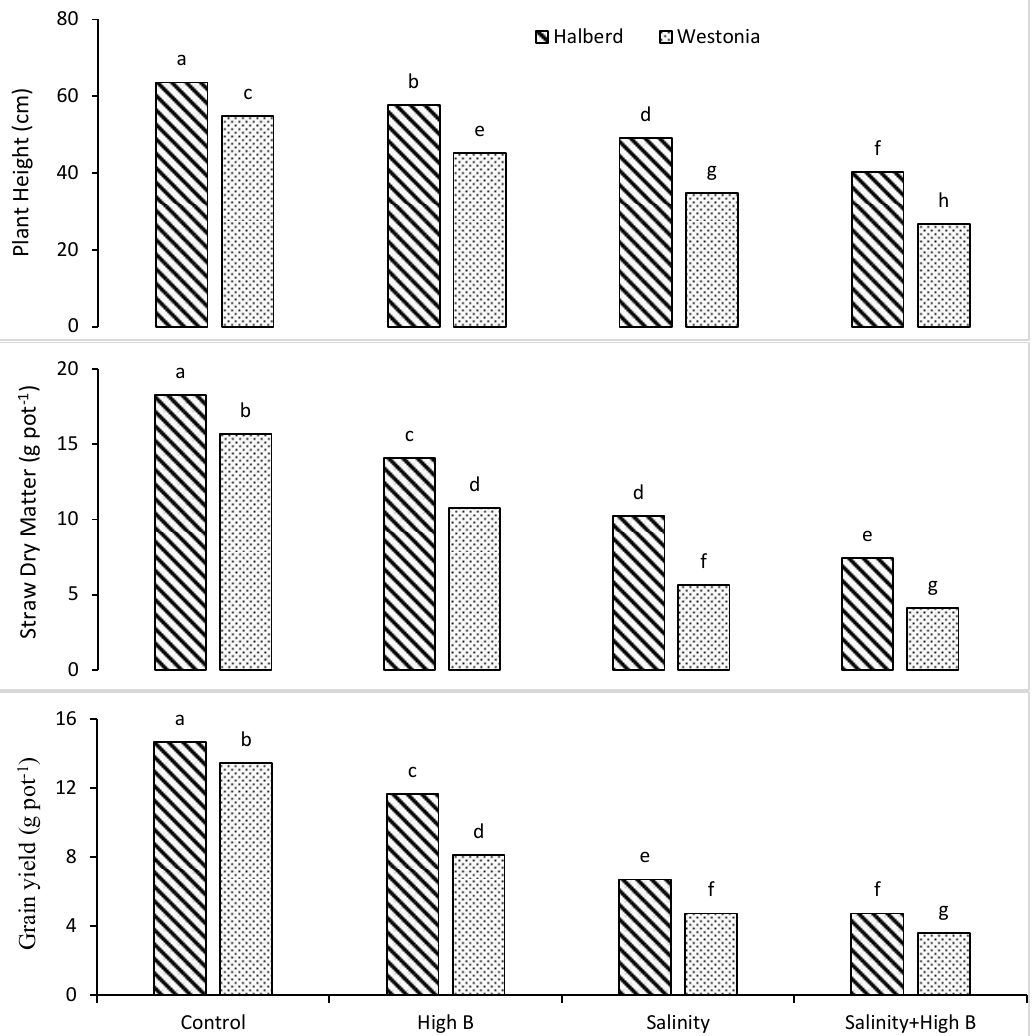
Figure 1. Impact of soil salinity and high B on the plant height, straw dry matter, and grain yield of wheat varieties (each value is a mean, n = 3 statistically significant at p ≤ 0.05, T bars represent ± standard error of means). Whereas, T 1 = control, T 2 = B at 7.5 mg kg −1 (high B), T 3 = 15 EC dS m −1 (salinity), and T 4 = 15 EC dS m −1 + B at 7.5 mg kg −1 (salinity + high B). Haldberd (HB), Westonia (WS).